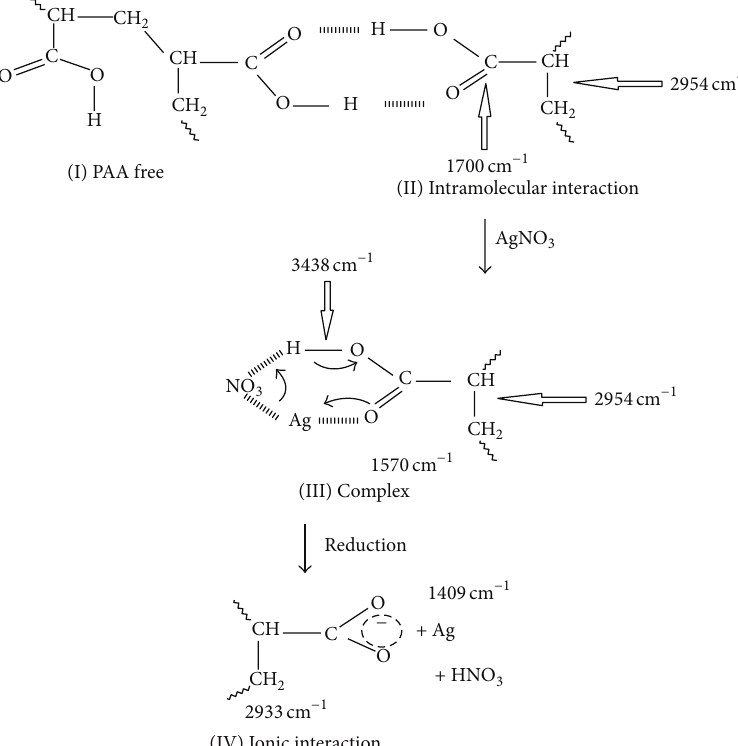
Scheme 1: Different types of association in the PAA/Ag nanocomposites as predicted by